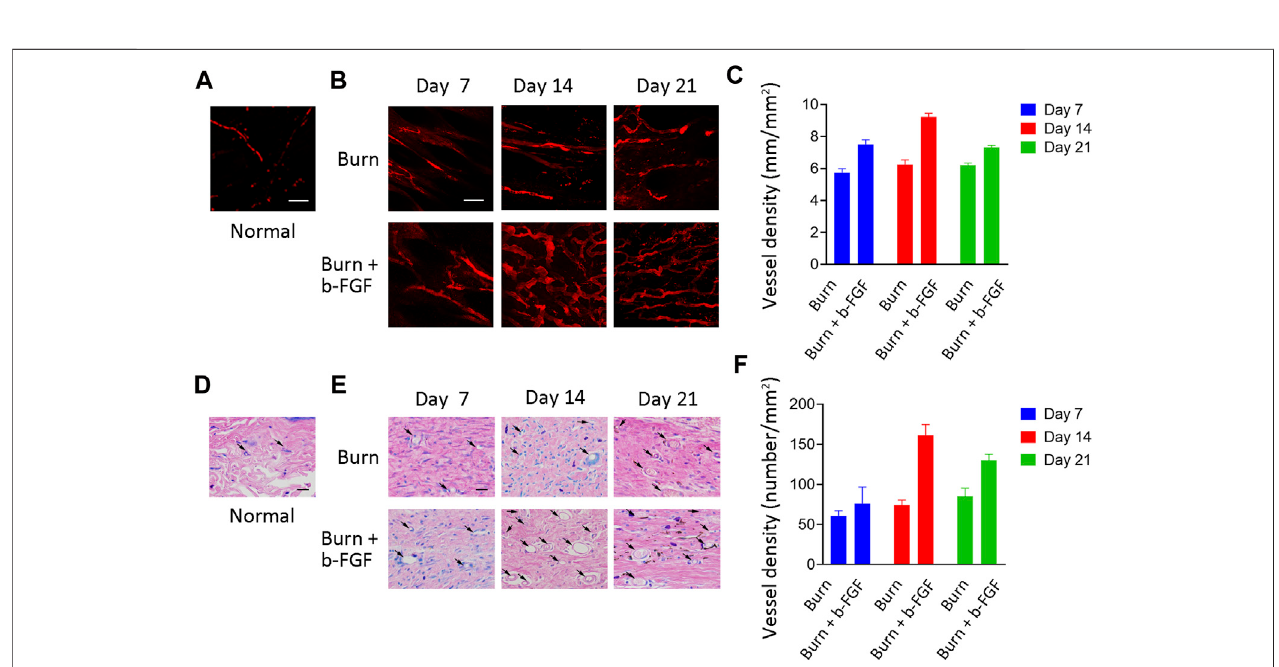
FIGURE 5 | Angiogenesis assessment of the deep burns by TPM and toluidine blue – eosin staining in mice. (A) Blood vessel image sets obtained in vivo which comprised of the TMP image stack in normal skin. Scale bar = 50 μ m. (B) Blood vessel image sets obtained in vivo which were comprised of the TMP image stack between the Burn group and the Burn + b-FGF group. Scale bar = 50 μ m. (C) Mean density of the blood vessels was analyzed from rhodamine – dextran imaging. (D) Blood vessel images of skin slices detected by toluidine blue – eosin staining in normal skin. Scale bar = 20 μ m. (E) Blood vessels images of skin slices detected by Toluidine blue – eosin staining between the Burn group and the Burn + b-FGF group. Scale bar = 20 μ m. (F) Number of blood vessels was analyzed from toluidine blue – eosin staining.